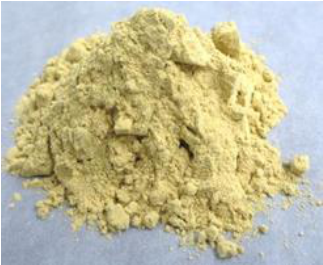
Figure 1. Kuding tea extract-γ-cyclodextrin (KTE)-complex used for the feeding study in mice.